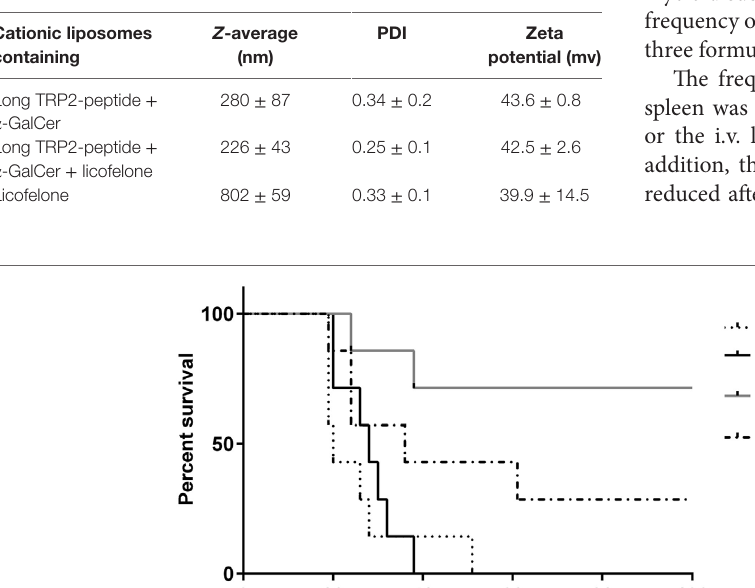
together with the TRP2-peptide and α -GalCer, did not markedly alter the size (243 ± 43 nm) or surface charge of the cationic liposomes. However, liposomes containing only licofelone alone were significantly larger (802 ± 59 nm, p <